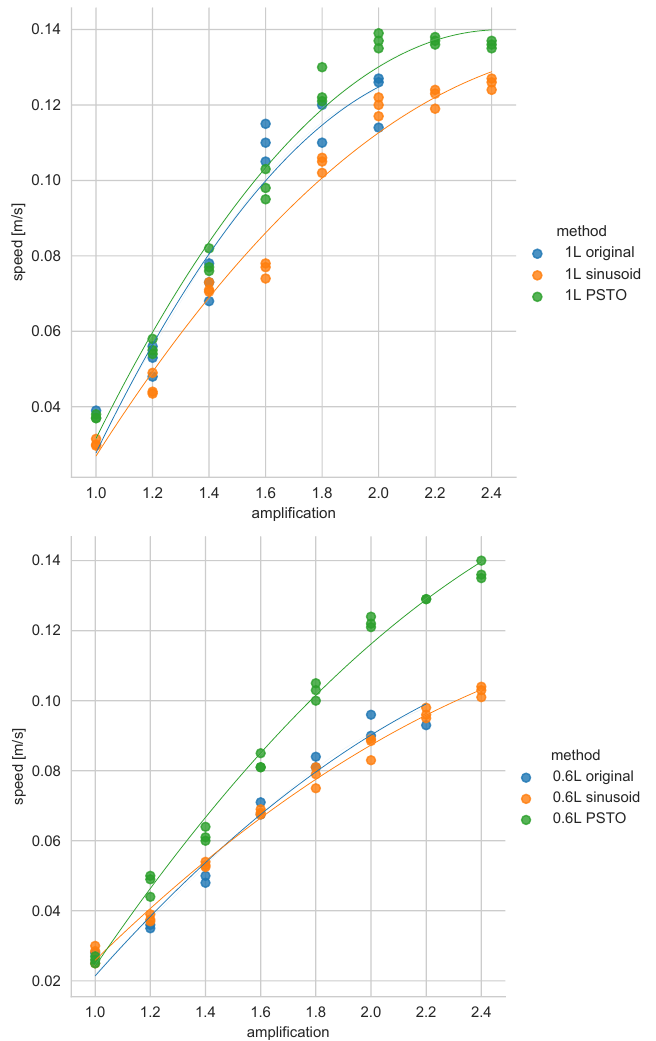
Figure 7. Speed [m/s] related to amplification for the original, sinusoid, and PSTO trajectories for 1 L leg length ( top ) and 0.6 L leg length ( bottom ) in the real-world experiments. The amplification range is from 1.0 to 2.4. The curves are the 2nd order polynomial regression for the tendency of three methods. PSTO can achieve a higher speed than the other two methods for different amplifications for both 1 L and 0.6 L leg length. Notice that the original trajectory has a larger variance which will exceed the control range of the actuator with a large amplification, so the robot can not conduct the full experiment following the original